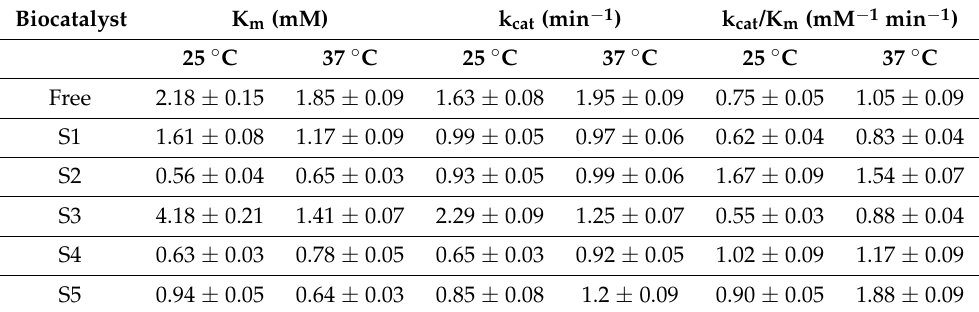
Table 2. Kinetic parameters of cold-active lipase for both free and immobilized forms at 25 ◦ C and 37 ◦ C, using 1/4 v / v lipase biocatalysts (see Section 3). (The experimental data were determined in